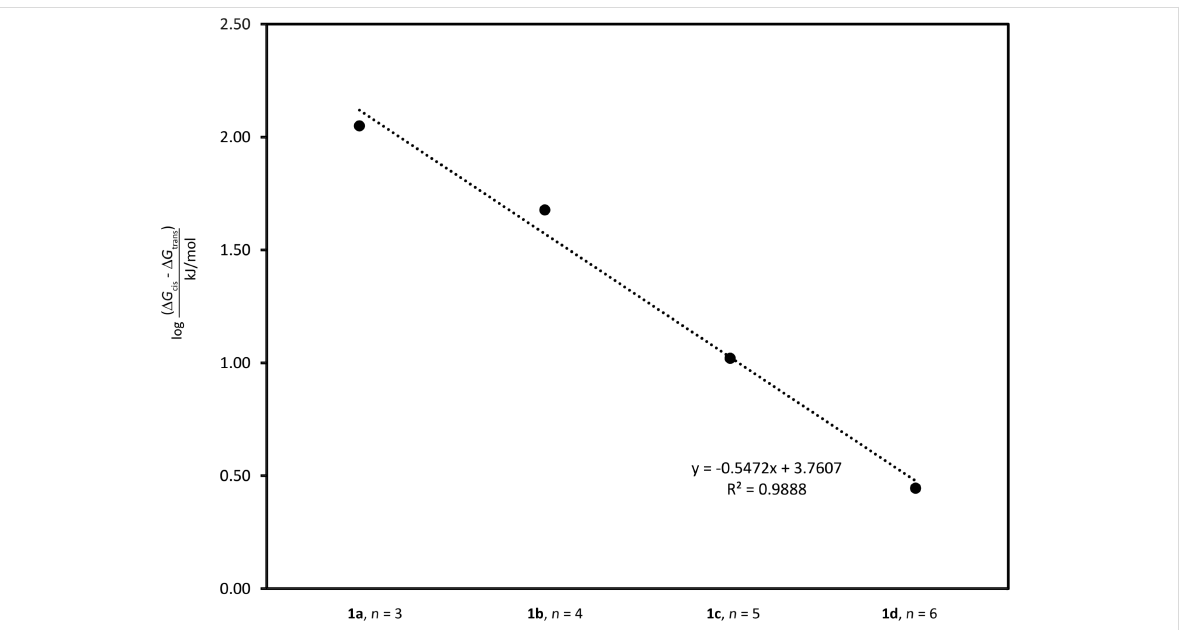
Figure 5: The differences in ring strain between the E- and Z- isomers show an exponential correlation to the linker length.